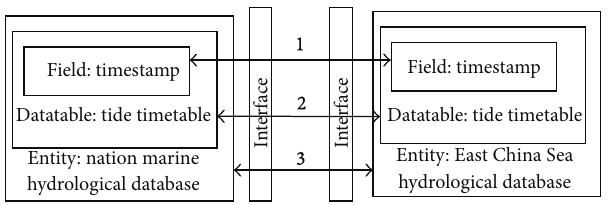
Figure 1: Digital ocean ETL mapping